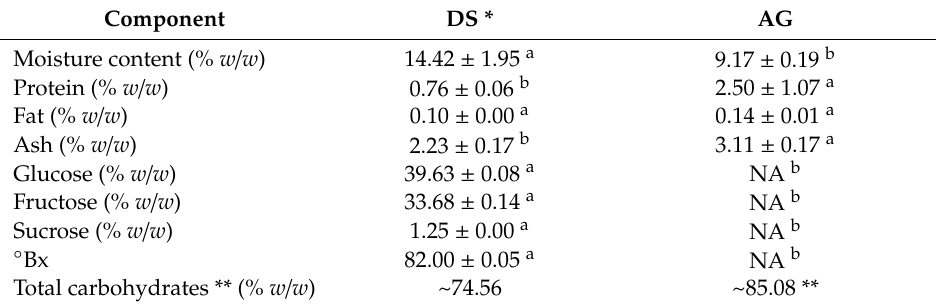
Table 2. Physicochemical properties of acacia gum and date syrup used in the present study.